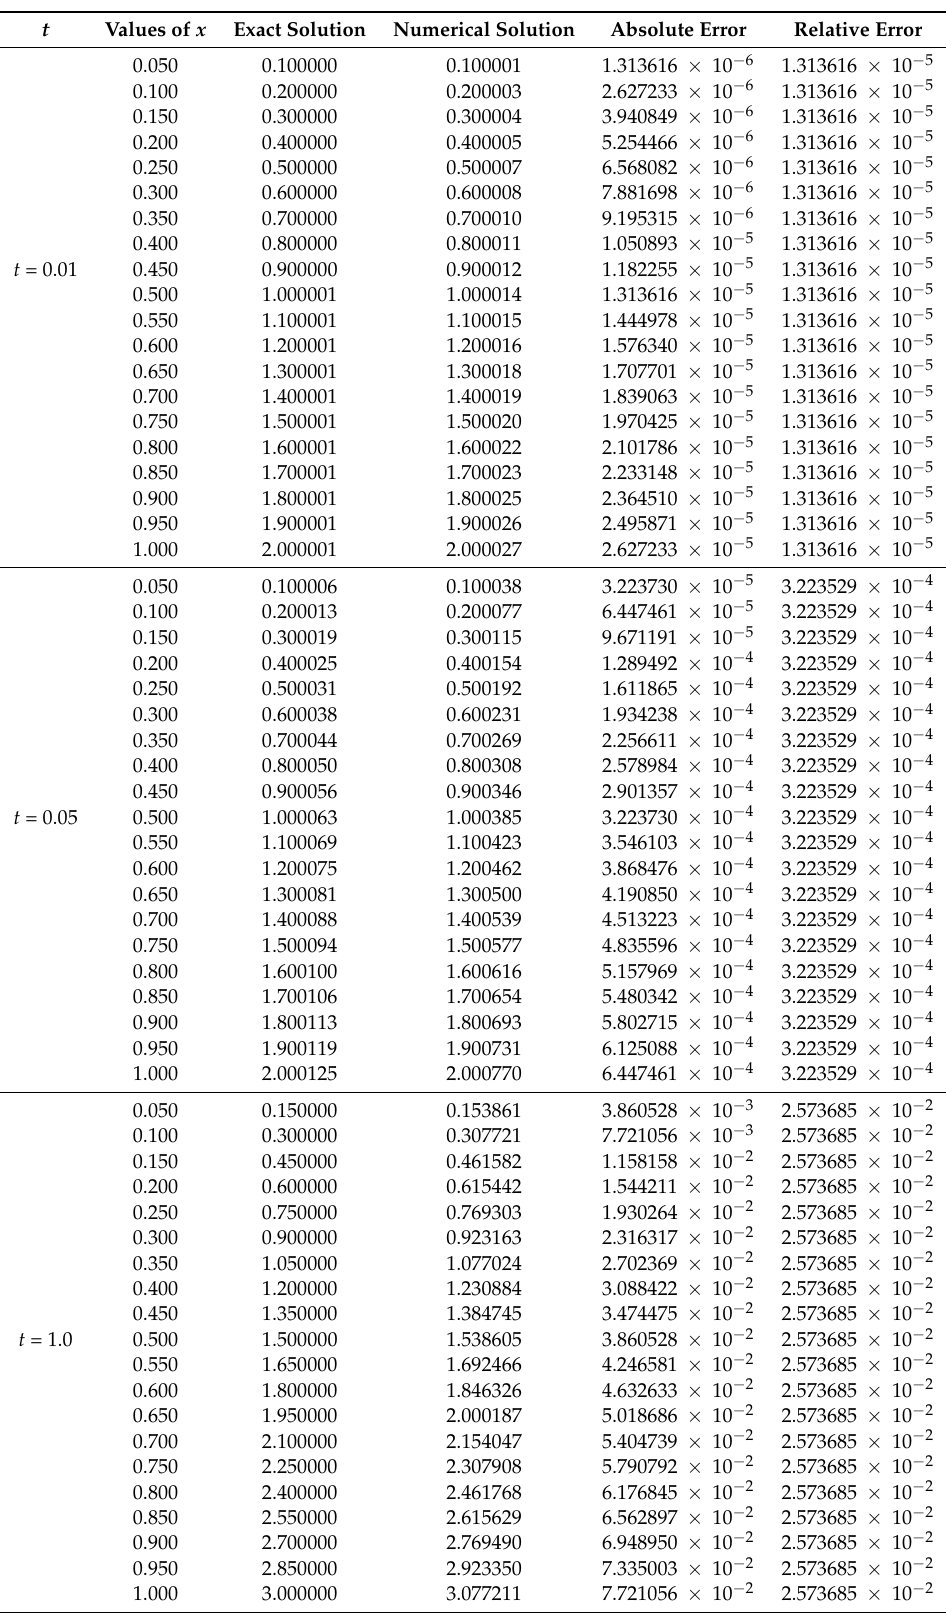
Table 7. Absolute and relative errors at some values of x obtained at times 0.01, 0.05, 1.0 using Ψ 5 ( x , t ) of BALDM (for numerical experiment